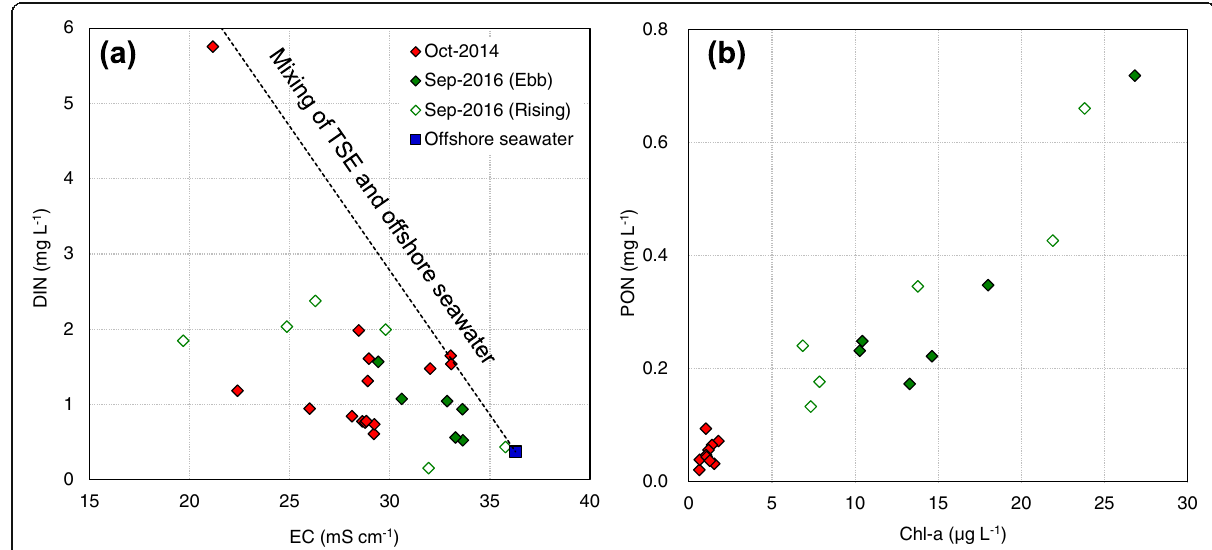
Fig. 6 Relationship between a the EC and DIN concentrations and b the Chl-a and PON concentrations in the surface seawater of the KH line in October 2014 and September